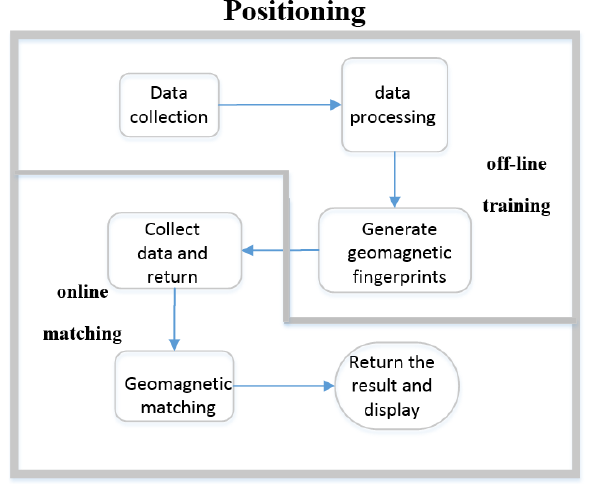
Figure 1. Flow chart of Indoor localization based on geomagnetic